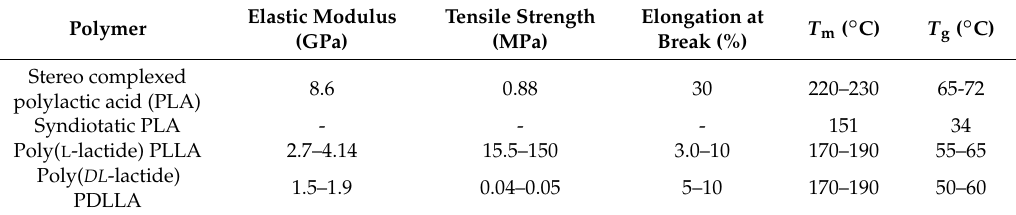
Table 1. Physical properties of PLA.